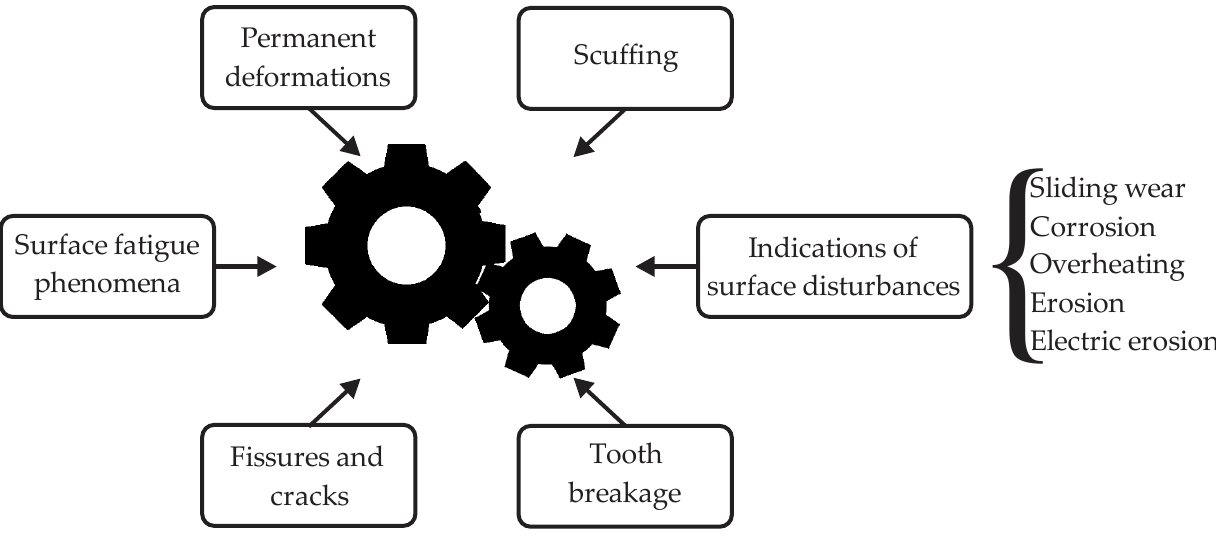
Figure 1. Failure modes according to ISO 10825 [37].